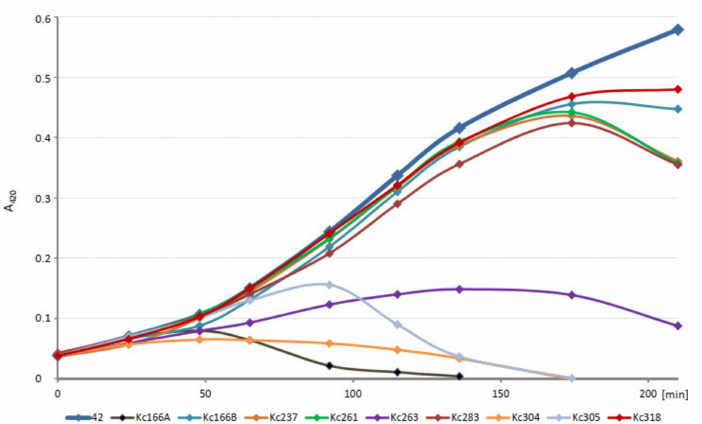
Figure 2. Kinetics of host cell lysis in liquid environment tested in 100 µ L of host culture inoculated with 10 6 each of phages and evaluated at A 420 nm. Absorbance of the uninfected host is in